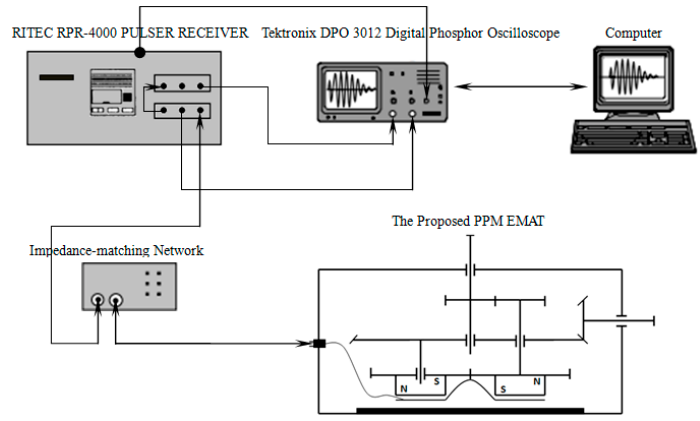
Figure 7. The experimental setups.